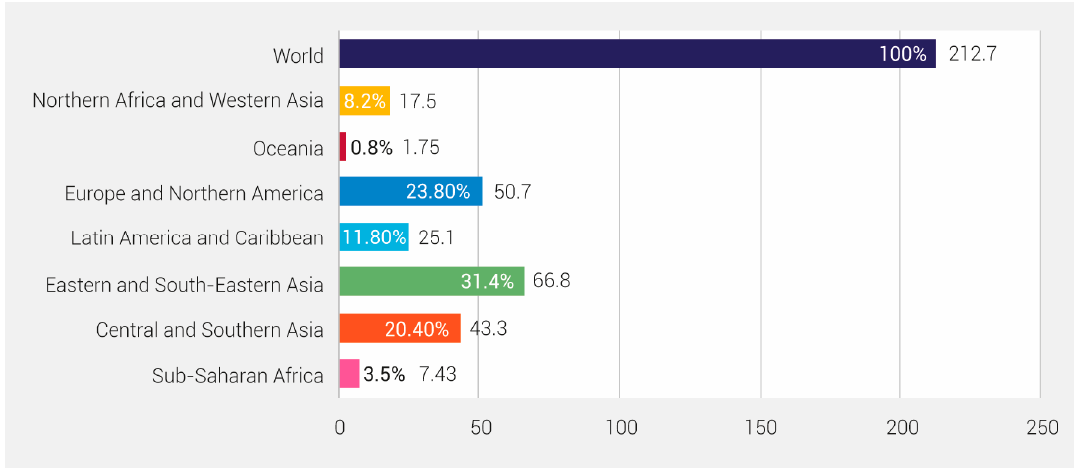
Figure 6. Students (millions, and % of global total) enrolled in tertiary education in SDG world regions in 2015. Source: [1] .